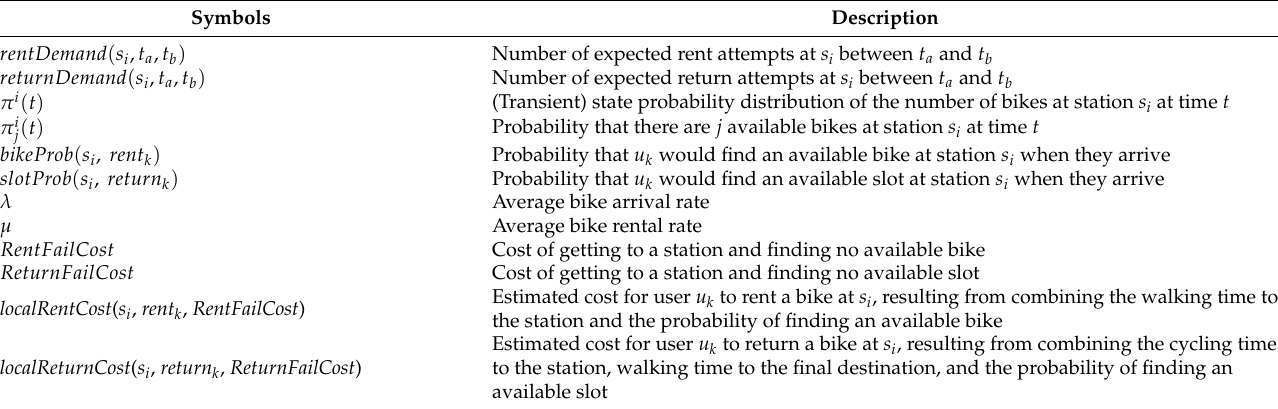
Table 2. List of symbols and functions